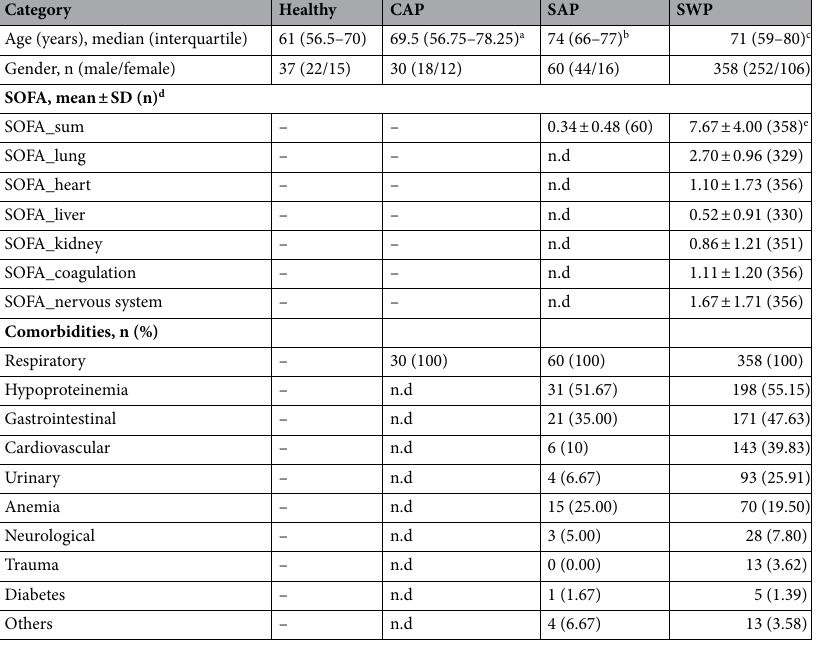
Table 1. Demographics, organ dysfunctions and comorbidities of human subjects. CAP community-acquired pneumonia, SAP sepsis-associated pneumonia, SWP sepsis with comorbid pneumonia, n.d. not defined.